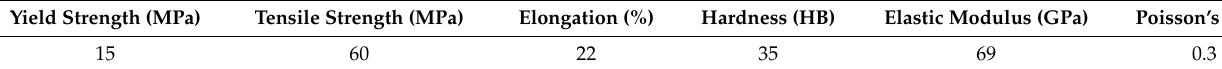
Figure 4. Shaping during roll forming.